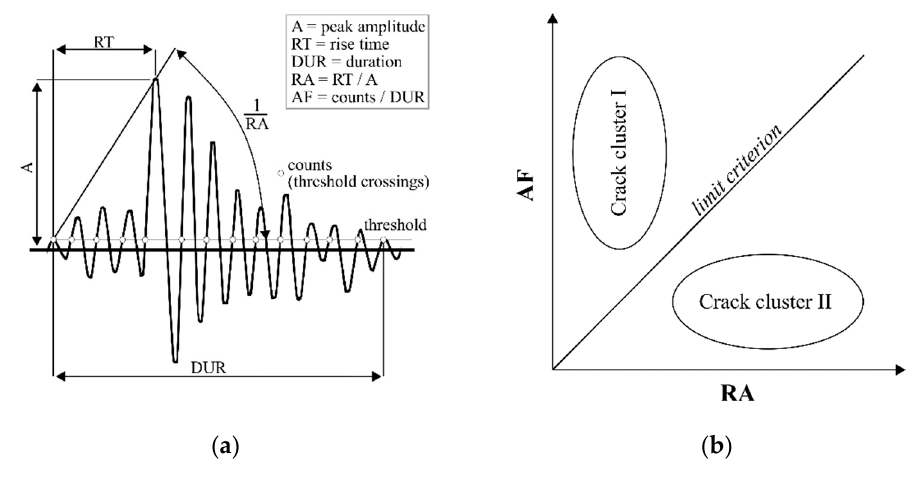
Figure 1. AE signal parameters ( a ); schematic diagram of clusters ( b ).